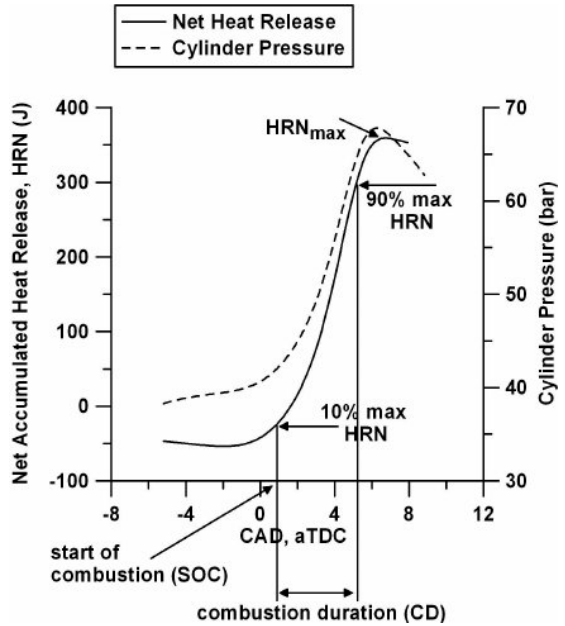
Figure 5. Start of combustion and combustion duration indicating net accumulated heat release and pressure history [34].